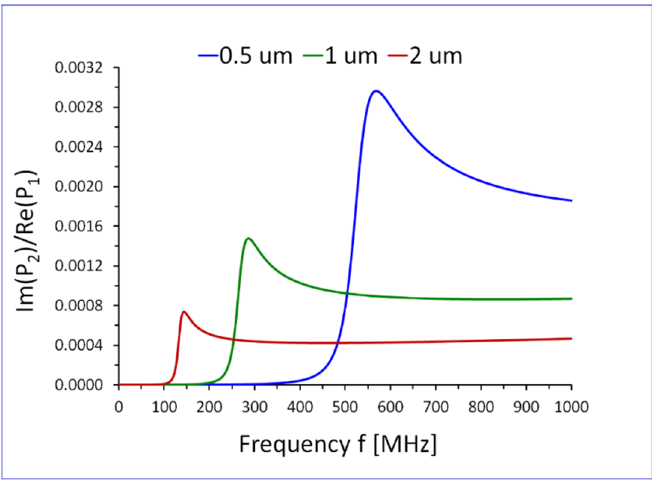
( 0 ) ( 0 ) Figure 3. Reactive part ImP of the average power flow P in the transverse direction x 2 , in the 2 2 Newtonian liquid, normalized by the active average power flow Re ( P 1 ) in the direction of propagation x 1 , in the entire waveguide, shown in Figure 1. The plots are drawn as a function of frequency f , for different values of thickness h 1 of guiding surface layer h 1 = 0.5, 1 and 2 µ m. The waveguide is loaded with a Newtonian liquid of density ρ 0 = 1000 kg/m 3 and viscosity η 0 = 1